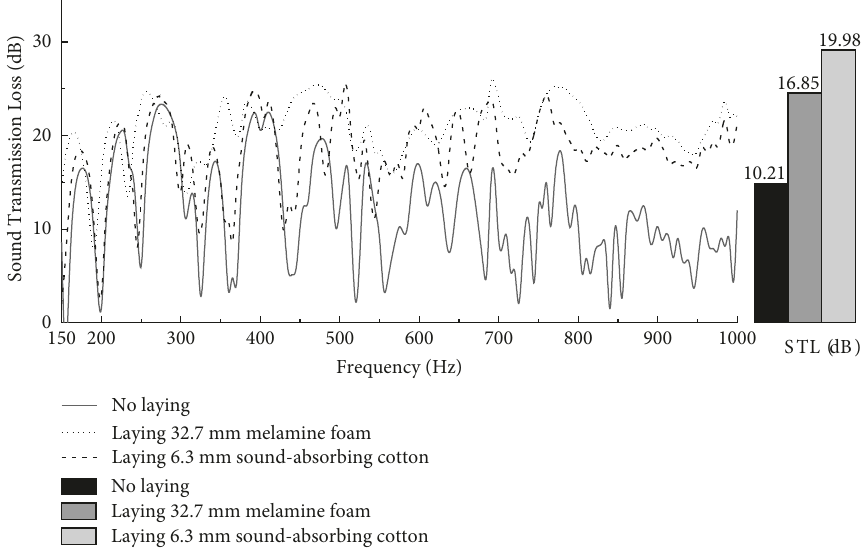
Figure 9: Comparison of laying the same mass of acoustic material for the sound transmission loss of cylindrical